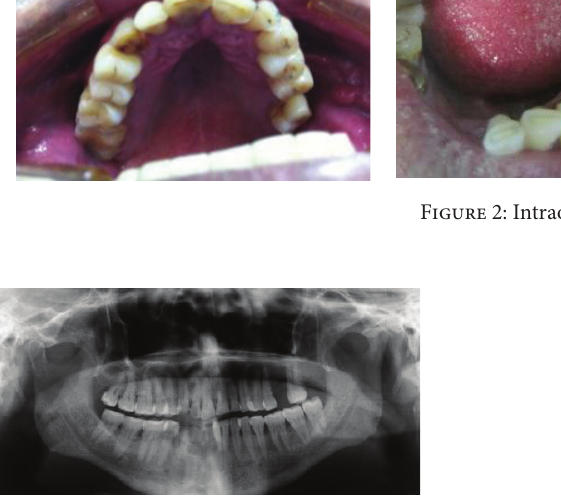
Figure 3: Preoperative OPG.